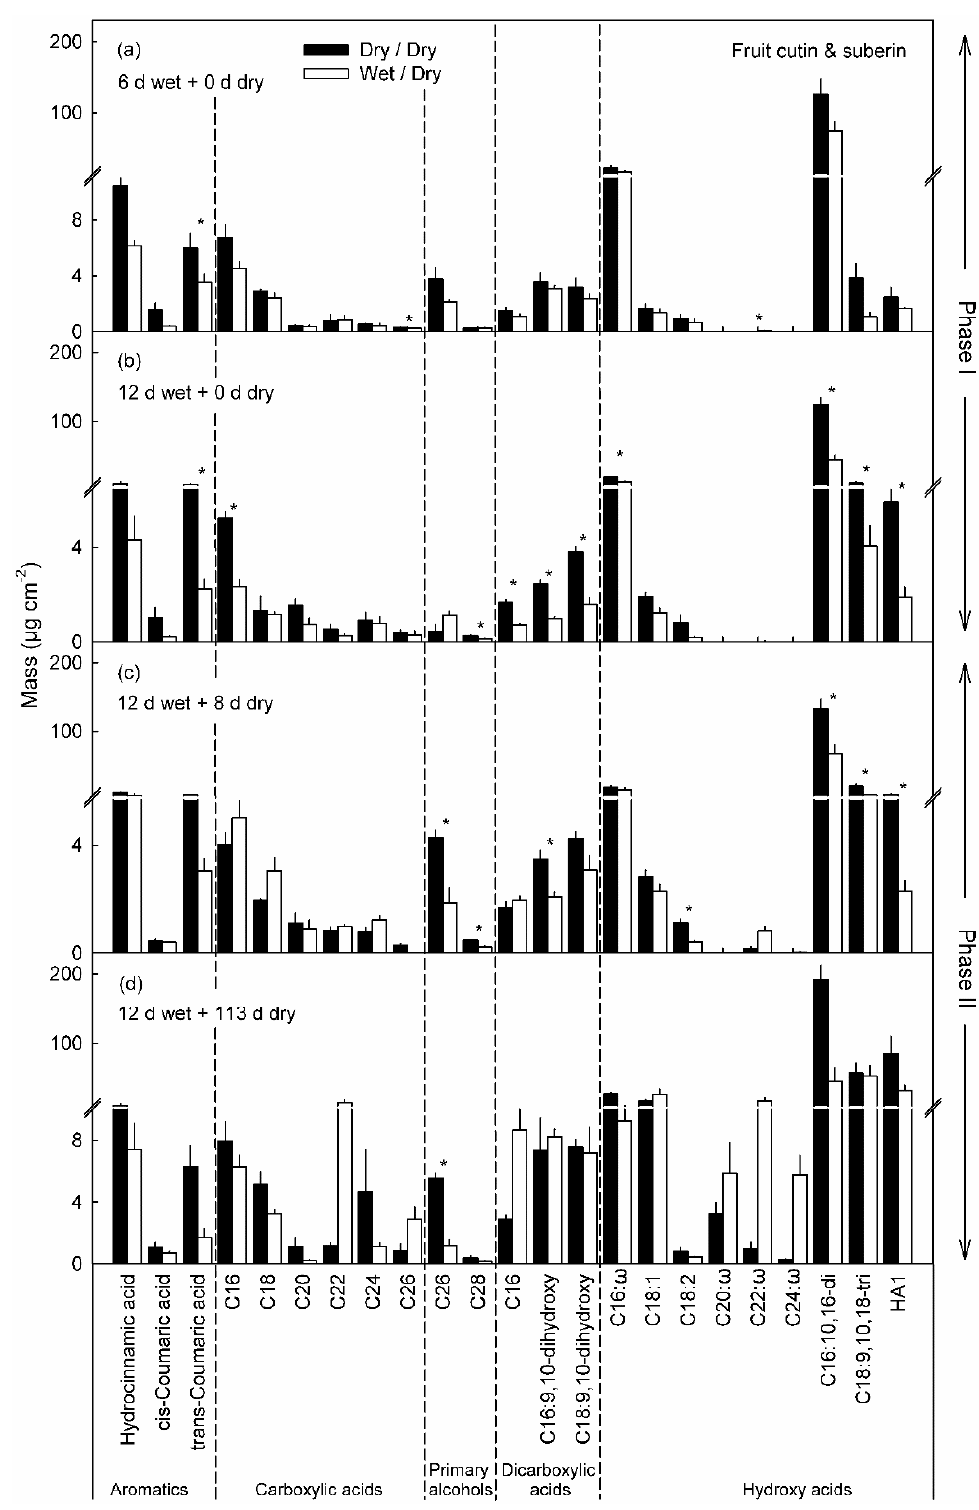
Figure 6. Cutin and suberin monomers in patches of apple fruit skin that were exposed to moisture for 6 d ( a ) and 12 d ( b ) (Phase I, wet). During the subsequent Phase II, the moisture exposure was discontinued (dry) and the cutin and suberin compositions of the patches analyzed after 8 d ( c ) and 113 d ( d ) after moisture exposure was discontinued. Unexposed patches of the fruit skin that remained dry throughout, served as controls (dry/dry). Data represent means ± SE of two to three replicates comprising cuticles of five fruit each. Significance of differences between dry/dry and wet/dry at p ≤ 0.05 are indicated by ‘*’ (Student’s t -test).